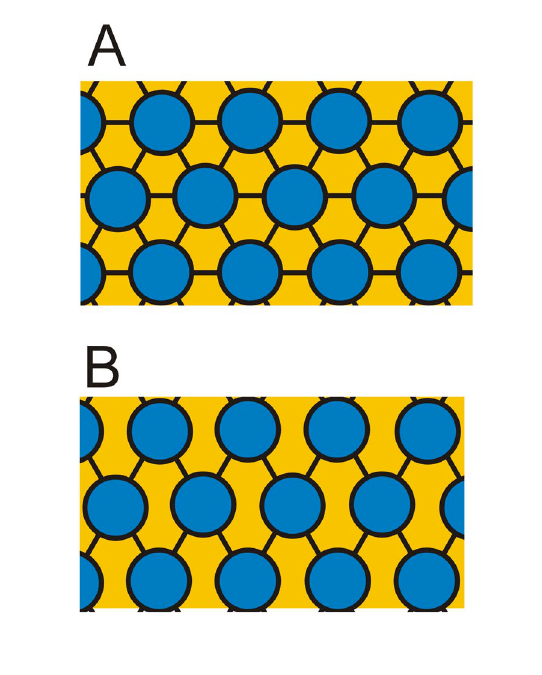
FIGURE 1. Sensory hair cell mosaics. All hair cells exist within cellular mosaics of sensory hair cells and nonsensory supporting cells. Diagrams depict the interactions between hair cells and supporting cells at the apical surface of the epithelium. (A) In most cases each hair cell (blue) is contacted by between five and seven supporting cells (gold). (B) However, in the mammalian cochlea, the number of supporting cells contacting each hair cell is limited to